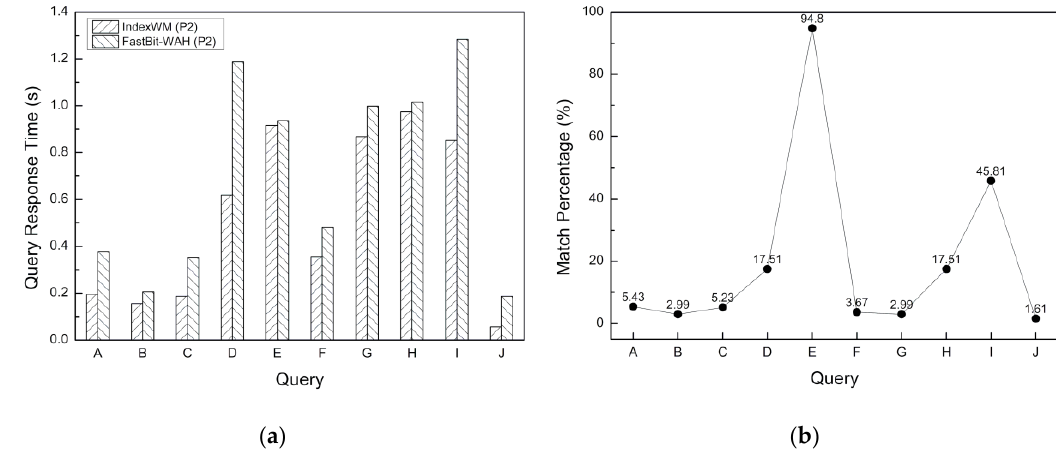
Figure 11. A comparison of query response time. ( a ) Query response time on dataset P2; ( b ) the percentage of matched packets on dataset P2.